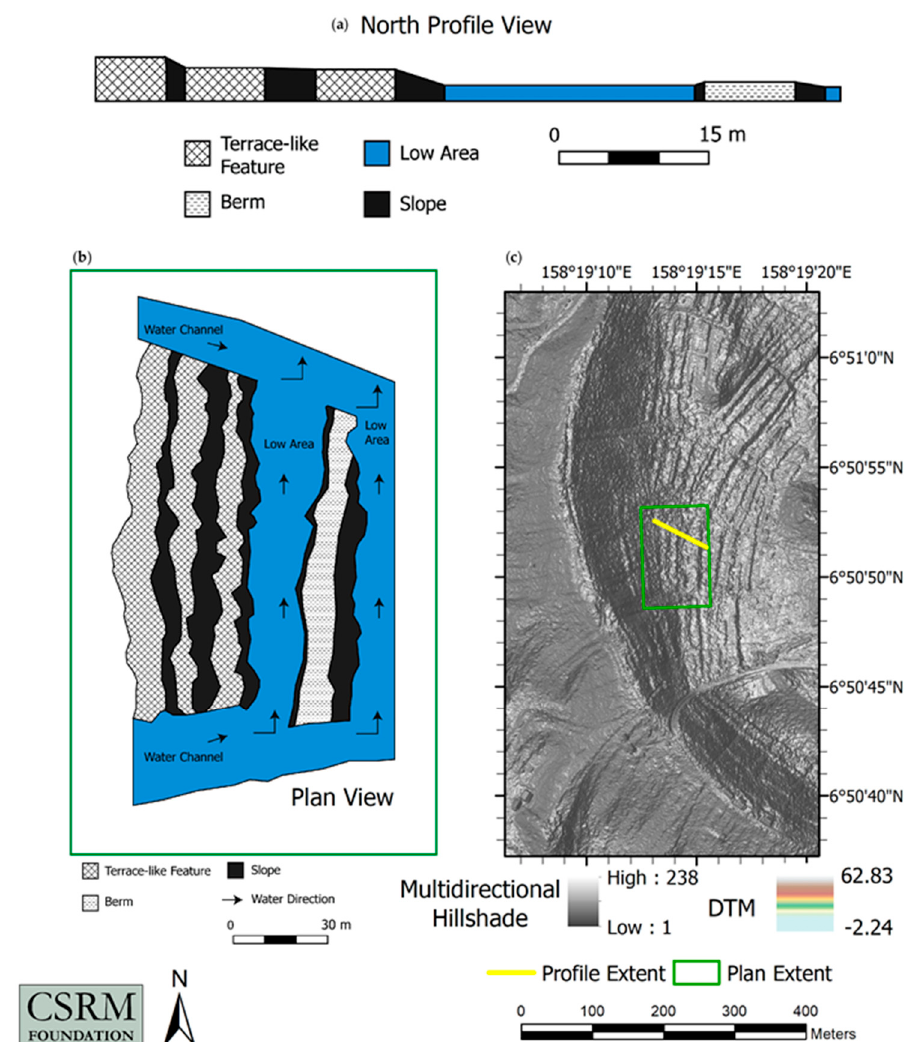
Figure 10. Large-scale landscape modifications in western Temwen Island. In ( a ), a north-facing profile of the terrace-like features, sloped areas, low areas, and berm that are depicted in the plan view in ( b ). In ( c ), the LiDAR-derived multidirectional hillshade, overlaid on the DTM, showing the locations of the profile and plan view. A day after heavy rain on Pohnpei, water was observed flowing through roughly west–east water channels, down the slope of the ridge in western Temwen. As shown in ( b ), the channels bisect terrace-like features. The channels run into low areas that alternate with berms on flatter ground below the ridge (the alternating pattern continues eastward). The low areas slope gently northward, bringing the water past a series of berms and crossing other west-east channels. If the terrace-like features were originally designed to draw water along their long axes, such water-drawing mechanisms are now